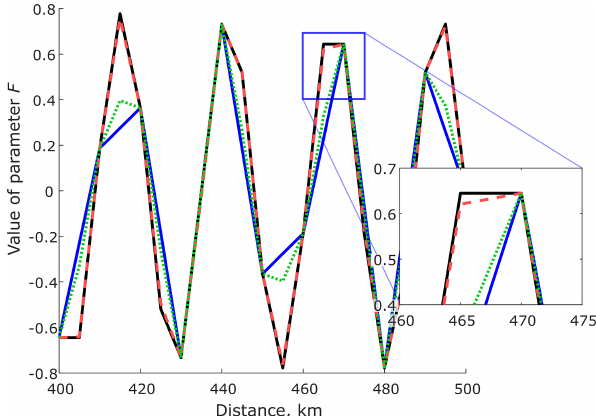
Figure 2. A zonal transect (see “detail transect” location in Fig. 1) showing the value of parameter F produced by three models: SDD model (dashed red line) and the coarse model bi-linearly interpo- lated (blue line) and bi-cubically interpolated (dotted green line) in comparison to the true solution (dashed black line) on the fine grid. Since SDD produces results almost identical to the true solution an inset with a zoomed region has been included to make the differ- ences more